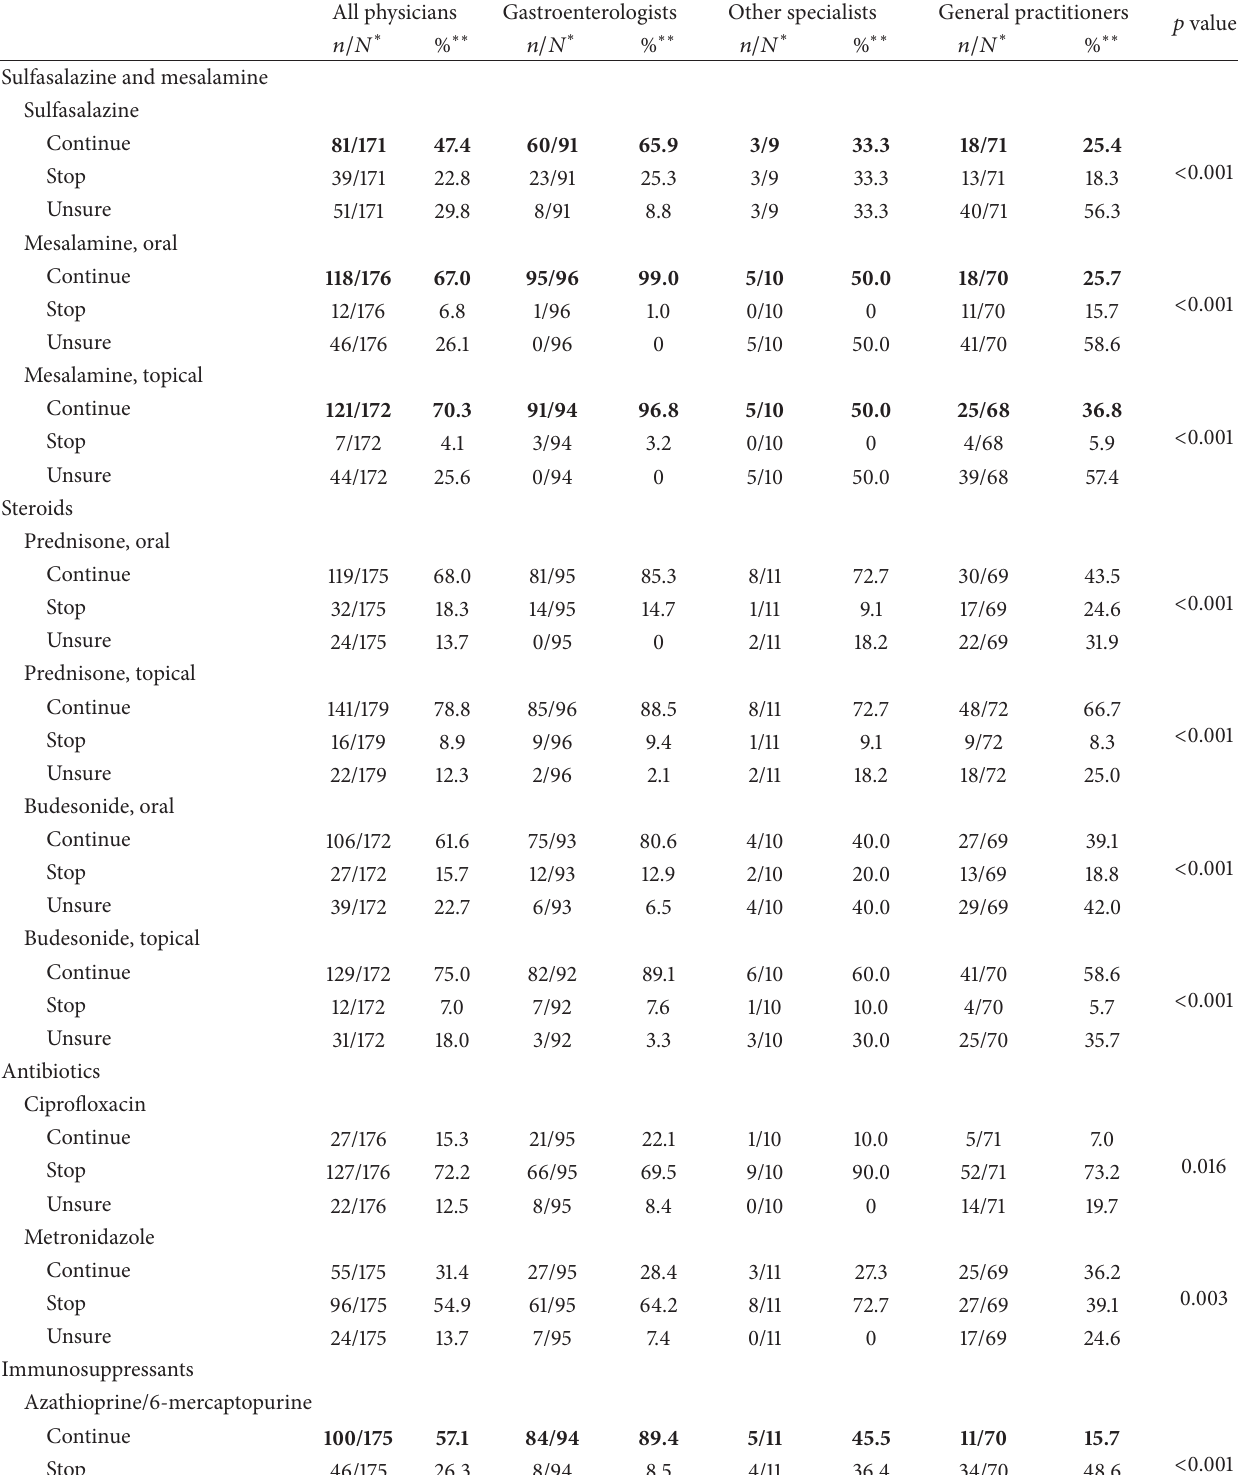
Table 3: Continuation of commonly used IBD medications for women with IBD during pregnancy by physician training status: a survey of practicing Canadian